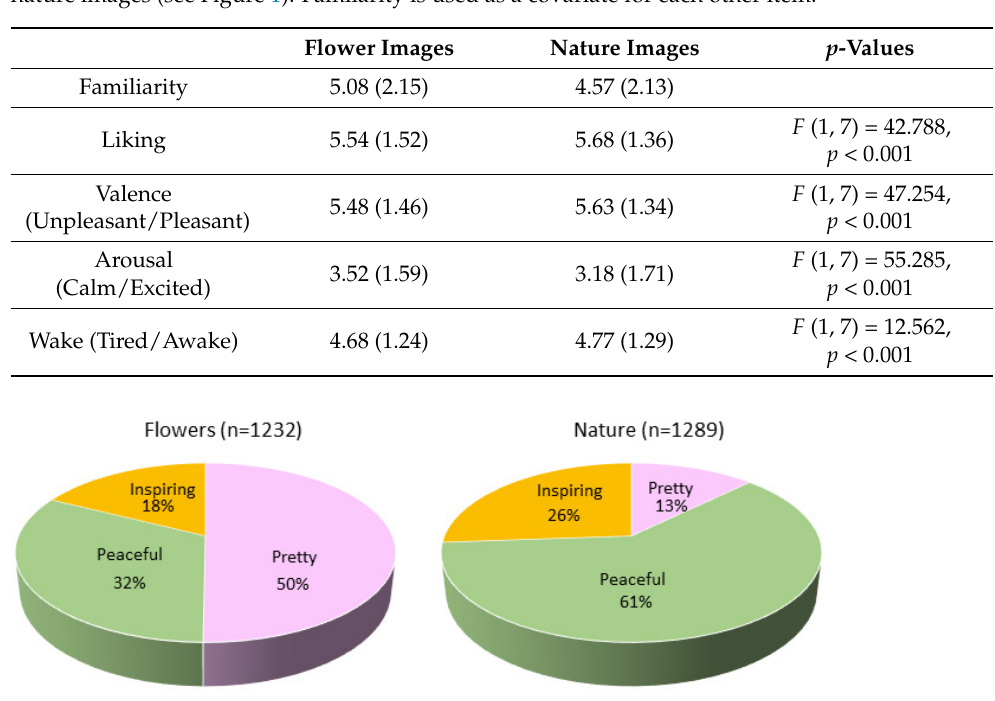
Figure 2. Occurrence (%) of the words most often chosen in relation to flowers (cultivated and wild) and nature (with and without flowers)